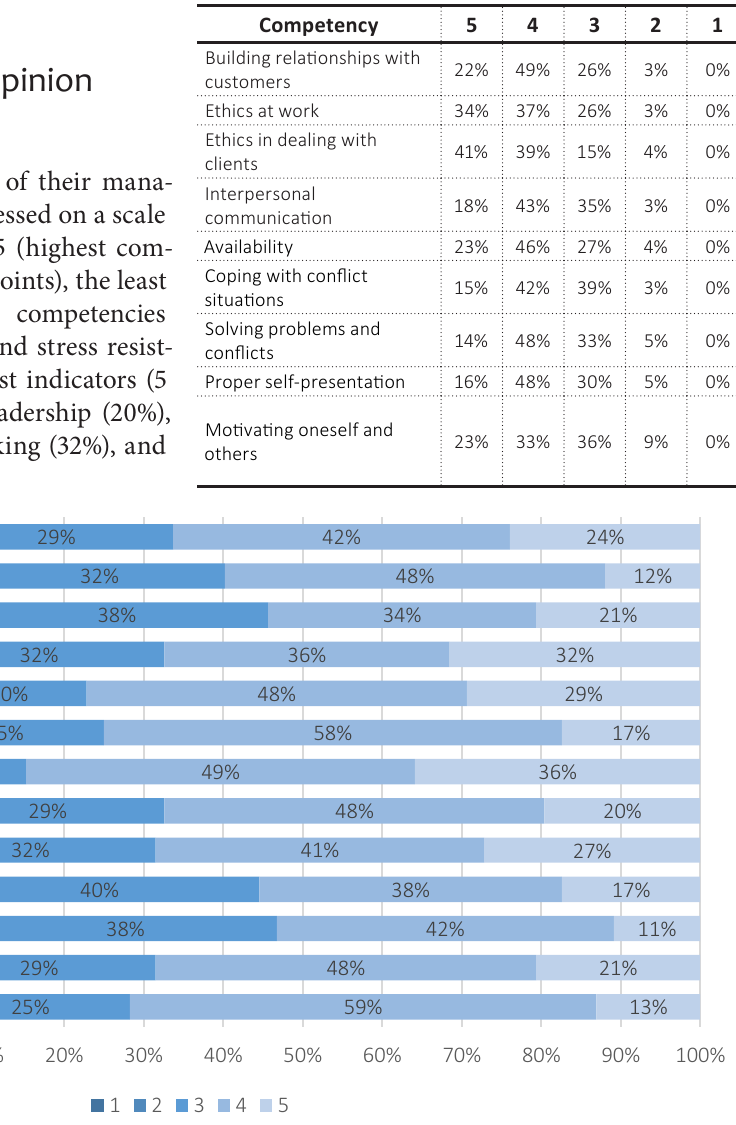
Source: Own study.